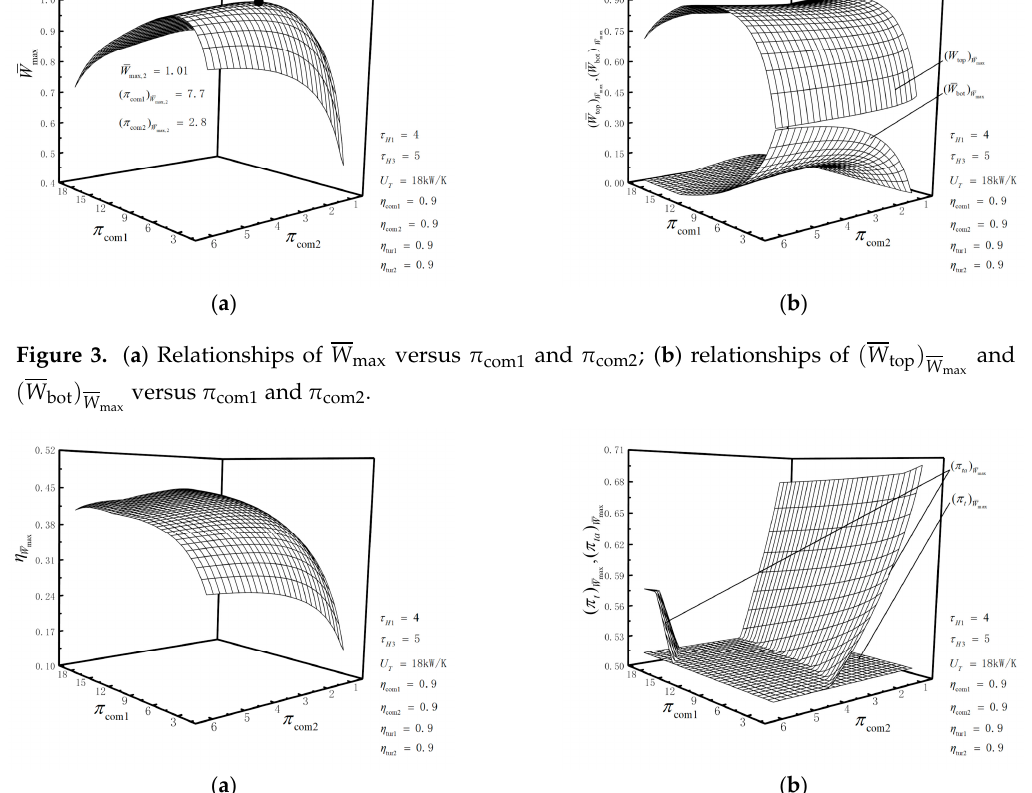
versus π com1 and π com2 ; ( b ) relationships of ( π t ) W max